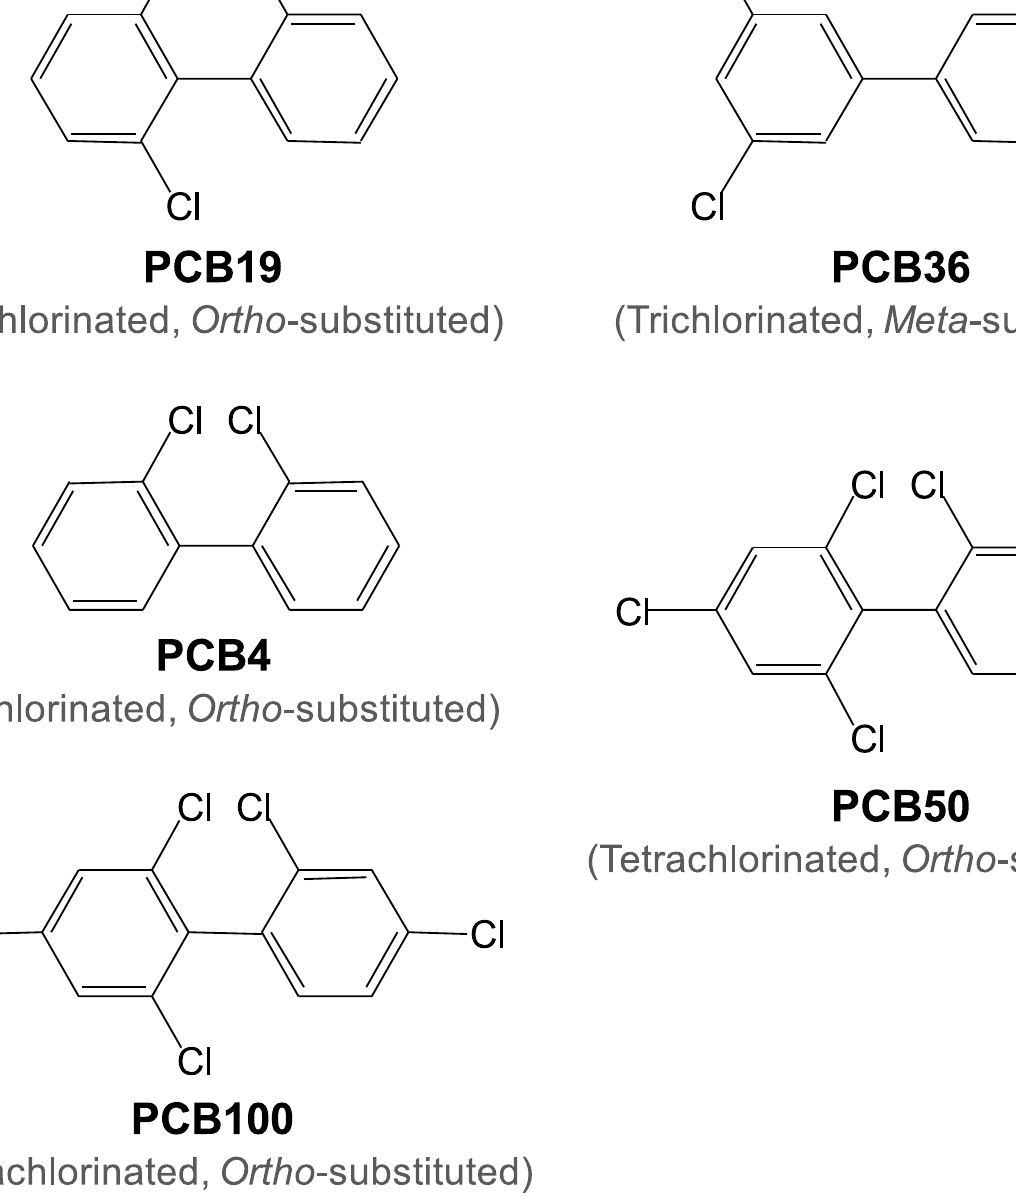
Fig 1. Structures of PCBs. PCB4 (2,2 ’ -dichlorinated biphenyl), PCB19 (2,2 ’ ,6-trichlorinated biphenyl), PCB50 (2,2 ’ ,4,6-tetrachlorinated biphenyl), and PCB100 (2,2 ’ ,4,4 ’ ,6-pentachlorinated biphenyl) have chlorine atoms at the ortho position of the phenyl ring, whereas PCB36 (3,3 ’ ,5-trichlorinated biphenyl) contains chlorine substitution at the meta position of the phenyl